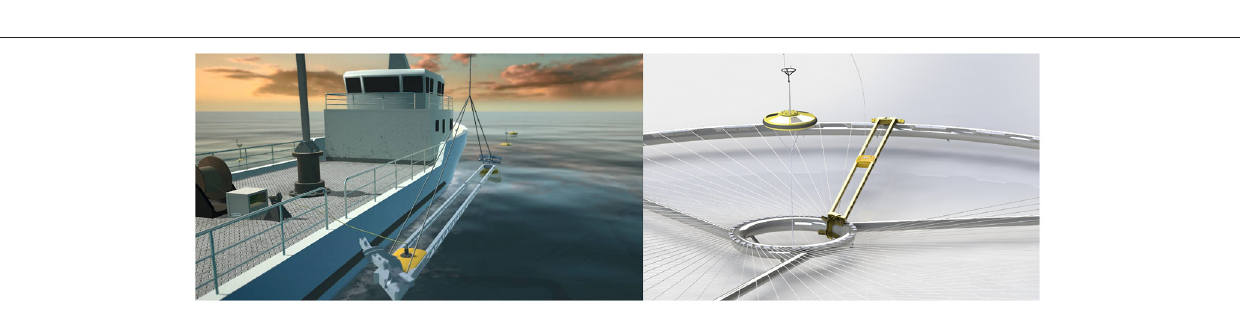
Selected units can be fitted with a data collection buoy, centrally positioned in the middle of a module. The